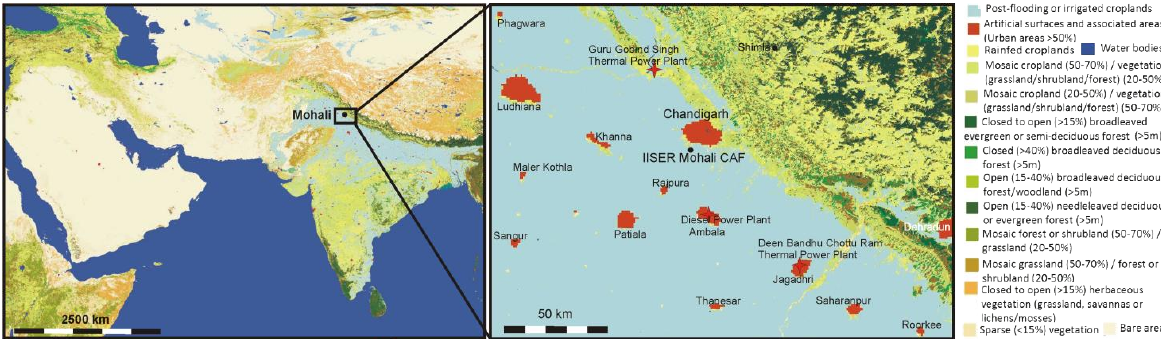
Figure 1. (Left) Location of Mohali on a land classification map (courtesy ESA GlobCover 2009 project). The site is located in the north- western Indo-Gangetic Plain, close to the forested slopes of the foothills of the Himalayan mountain range. (Right) Exact location of the measurement facility and its spatial relationship with respect to the nearby cities, the mountain range and potential local point sources of particulate matter.